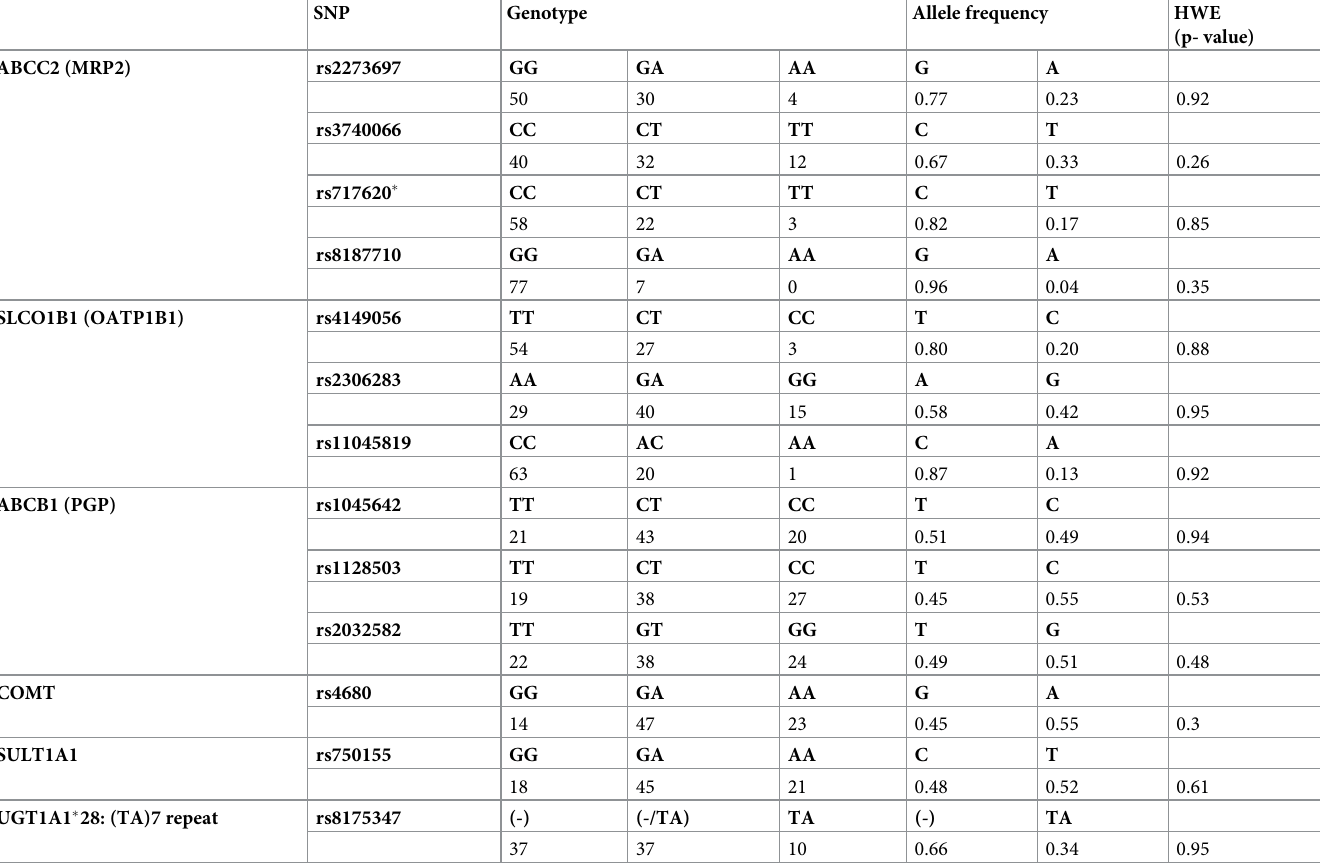
Table 4. Distribution of allele frequencies in the study population.